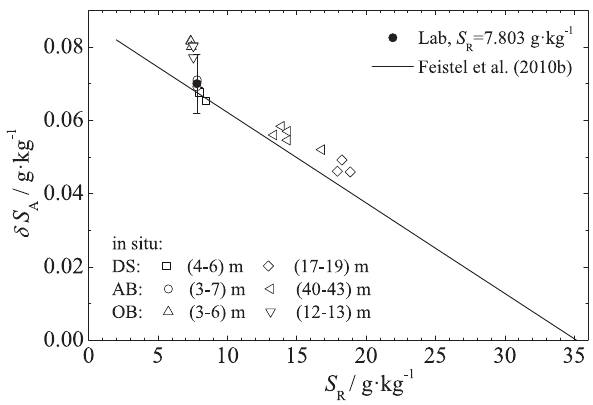
Figure 3. Salinity anomaly, determined from density and salinity measurements, vs. reference salinity S R = S P × u PS . Filled symbol: laboratory sample; open symbols: Baltic field samples. The straight line shows the parameterization of Feistel et al. (2010b), Eq. (1), for